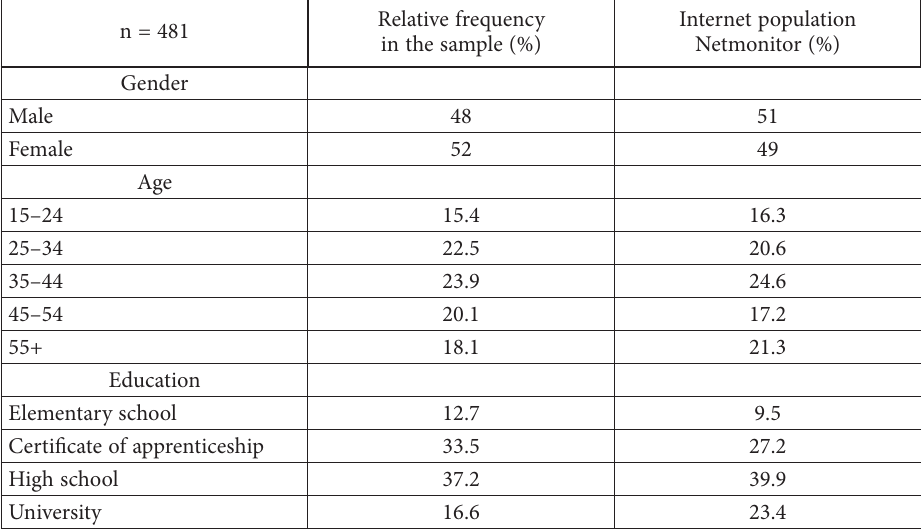
Table 1. Sample structure in comparison with internet population (source: own research) n =